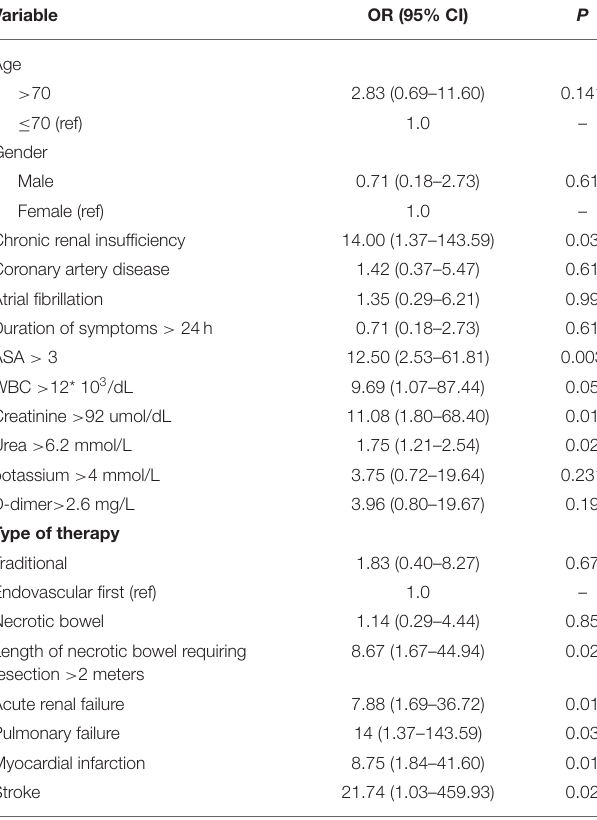
TABLE 3 | Outcomes of treatment stratified by treatment type.